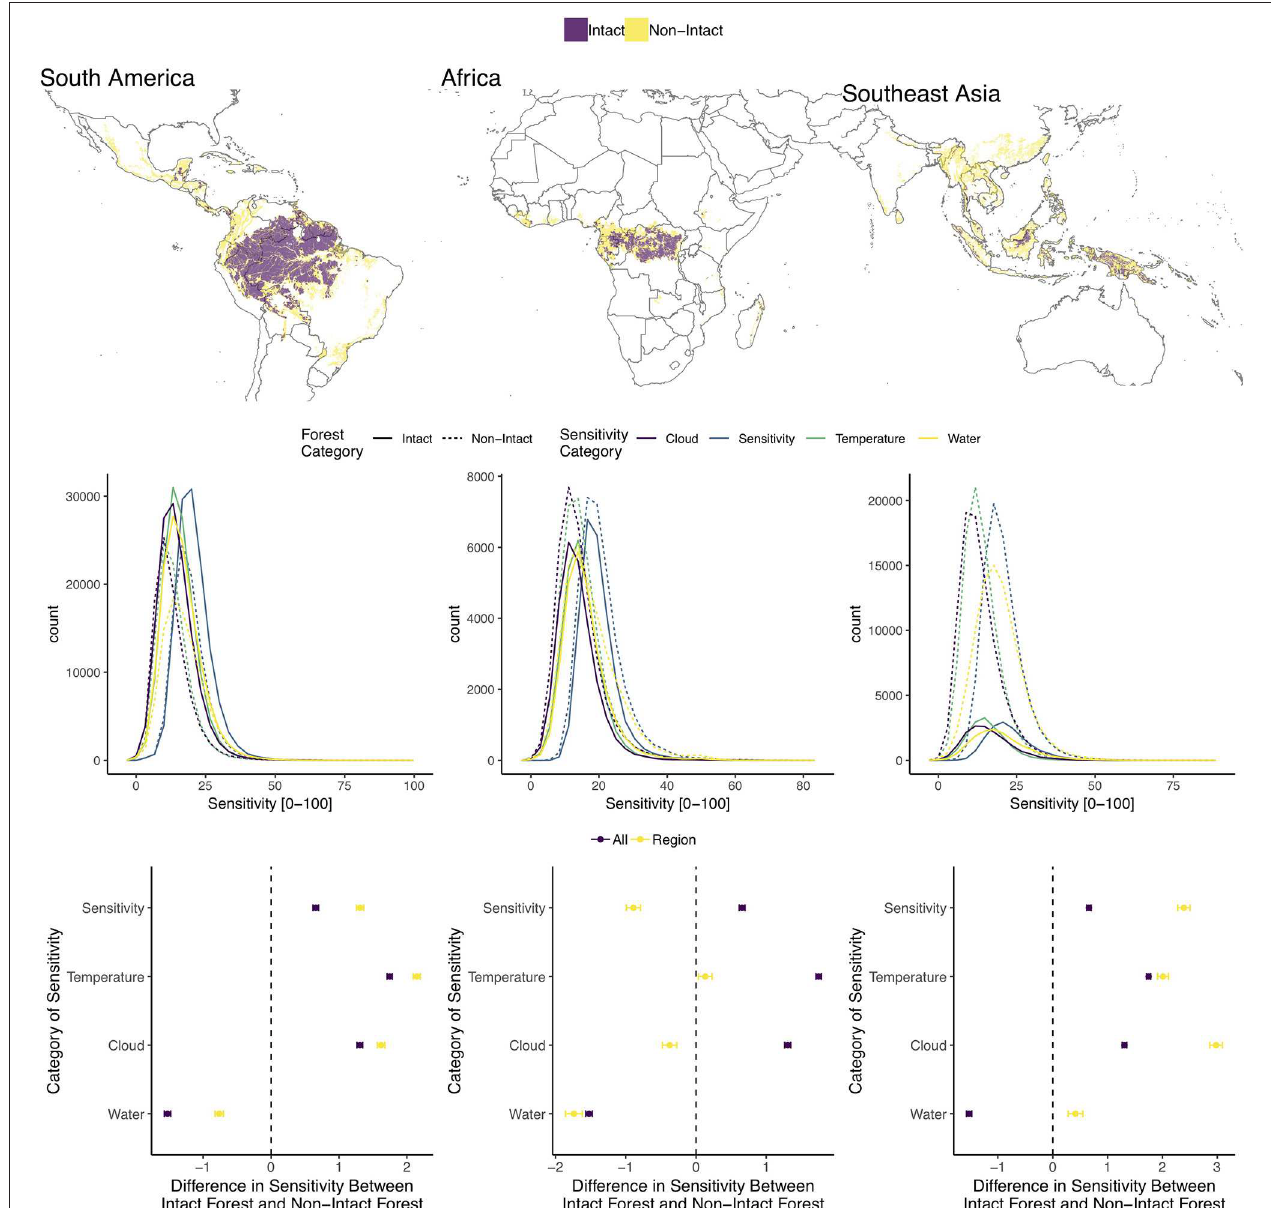
FIGURE 1 | (Top row) Distribution of intact and non-intact pixels for each analyzed continent across the tropics. (Middle row) Histograms of four climate sensitivity metrics for intact (solid) and non-intact (dashed) forests for each continent. (Bottom row) TukeyHSD values, with confidence intervals, comparing climate sensitivity of intact and non-intact forests for each climate sensitivity metric for all (“All”) forest pixels across the tropics and for each continent (“Region”). Negative values indicate intact forest pixels exhibited lower sensitivity for each variable and positive values indicate non-intact forest pixels exhibited lower sensitivity.